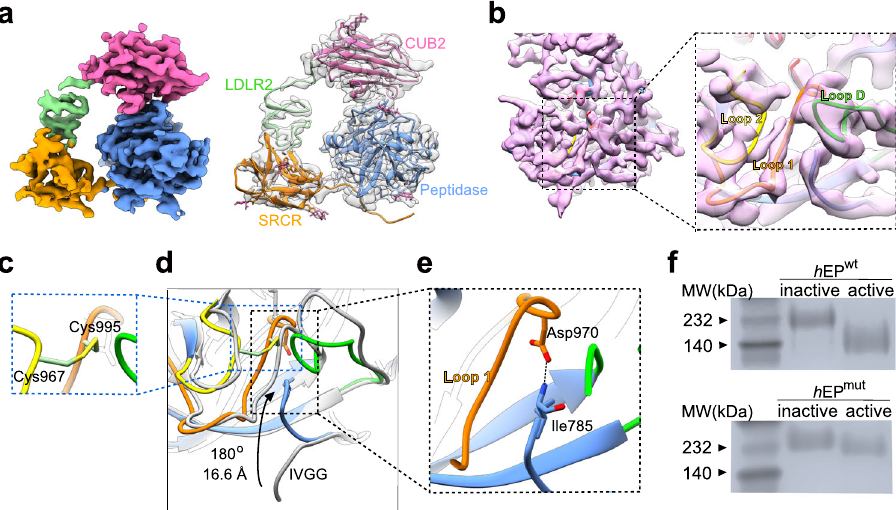
Fig. 2 | Mechanism of the activation of h EP. a Cryo-EM reconstruction of the active h EP wt -core,withastructuralmodel fi ttedin. b Thepeptidasedomainportion ofthisreconstruction fi ttedwiththecorrespondingmodel,withtheinsetshowinga magni fi ed view of the portion of this domain containing surface loops L1, L2, and LD. c Depictionoftheinter-domaindisul fi depairCys967-Cys995,afeatureforming the wall of the catalytic pocket. d Comparison of the structures of the catalytic pockets of active (with different colors) and inactive (grey) states. The black arrow